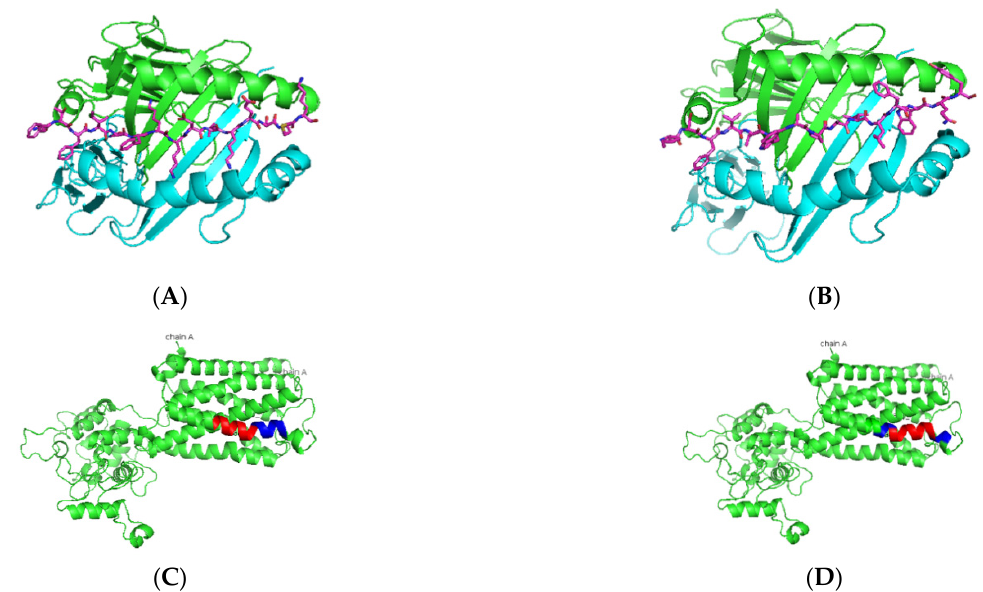
Figure 4. Predicted M3R peptide binders docked on HLA-DRB1*0103. ( A , B ) Based on the prediction by SMM-align using IEDB the top two peptides with IC50 values of 120 and 121 were docked onto the crystal structure of HLA-DRB1*0103 PDB structure 1A6A, and the most optimum predicted position of docking is indicated for both peptides AWVISFVLWAPAILF and ISFVLWAPAILFWQY with the core sequence of AWVISFVLW and VLWAPAILF, respectively. ( C , D ) The highlighted region indicates the presence of the peptides in the three-dimensional structure of the M3R protein.